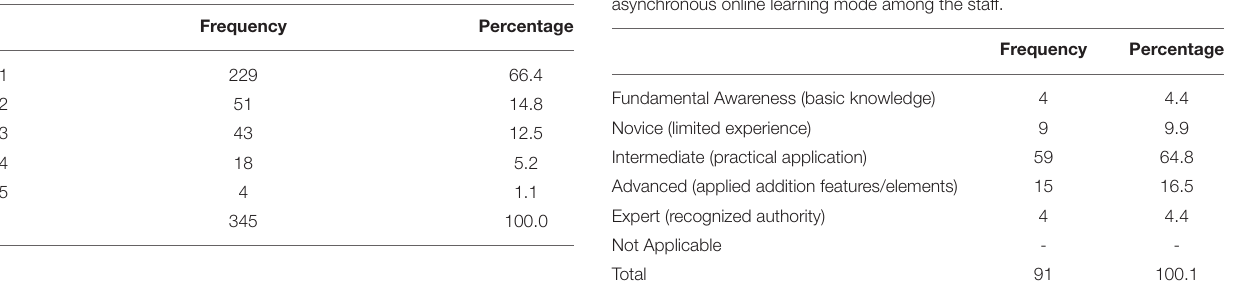
TABLE 3 | Years of studies.